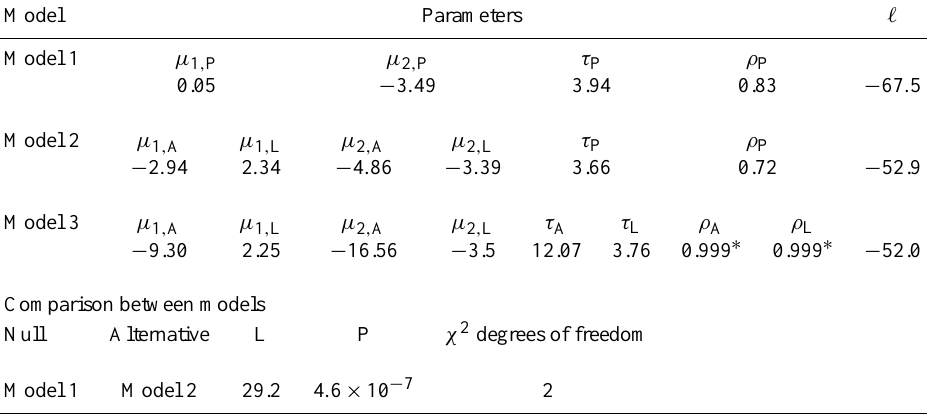
Table 4. Projected normal distributions fitted to Bangladesh anticline axial plane and Landsat-derived lineament orientations (doubled direc- tions). Subscript “A” for a parameter denotes that it pertains only to observations of anticline axial plane orientations, subscript “L” denotes a parameter of the distribution of Landsat lineaments, and subscript “P” denotes a pooled